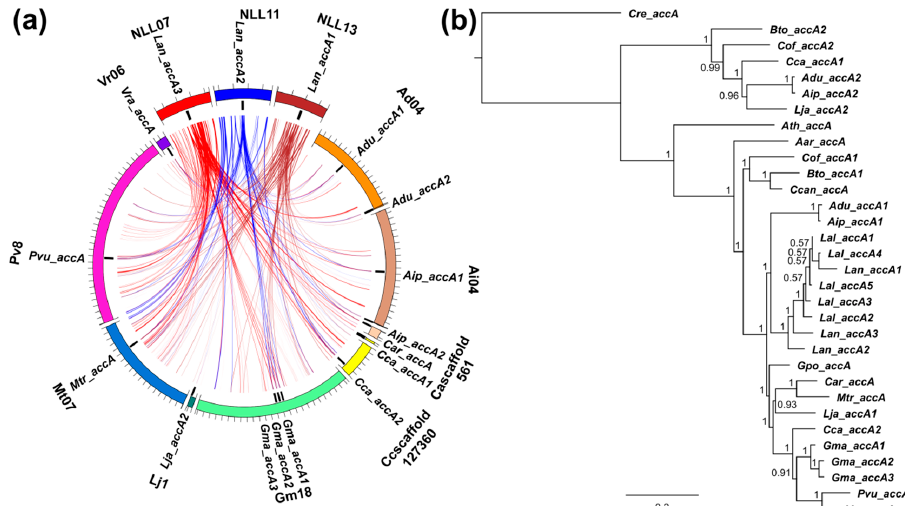
Figure 6. Comparative mapping and phylogenetic inference of legume alpha carboxyltransferase ( accA ) subunit genes of plastid ACCase. ( a ) syntenic patterns revealed for narrow-leafed lupin genome regions and corresponding regions of legume chromosomes. Abbreviated species names are provided as follows: Aar, Acacia argyrophylla ; Adu, Arachis duranensis ; Aip, A. ipaensis ; Ath, Arabidopsis thaliana ; Bto, Bauhinia tomentosa ; Car, Cicer arietinum ; Cca, Cajanus cajan ; Ccan, Cercis canadensis ; Cof, Copaifera officinalis ; Cre, Chlamydomonas reinhardtii ; Gma, Glycine max ; Gpo, Gompholobium polymorphum ; Lal, Lupinus albus ; Lan, L. angustifolius ; Lja, Lotus japonicus ; Mtr, Medicago truncatula ; Pvu, Phaseolus vulgaris ; Vra, Vigna radiata . ACCase gene loci are indicated by black bars. Ribbons visualize homologous links identified by DNA sequence alignments. L. angustifolius genomic sequences and homology links are marked by colors: red, blue and brown. ( b ) majority rule consensus tree found in a Bayesian analysis of legume accA genes. Numbers are posterior probabilities. The length of MAFFT alignment was 2445